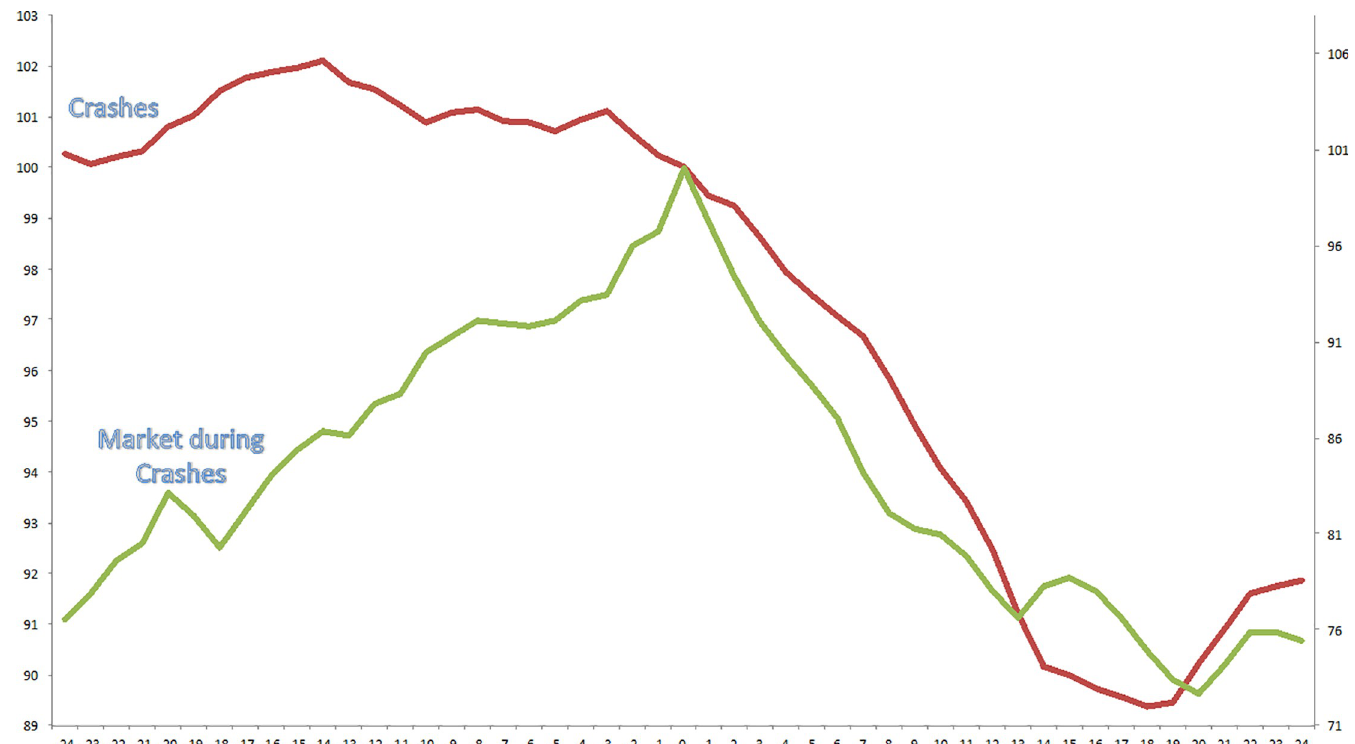
Fig 2. Fear and Euphoria during crashes (1959–2014). The Figure plots cumulative returns to the Euphoria Index EIx (left axis) and the S&P500 (right axis) during periods when US industries experience a large price run-up and a subsequent crash. The sample includes all industries between 1959 and 2012 and is based on Fama and French [39] 49-industry classifications. 30 episodes are identified in which an industry experiences both a raw and net-of-market return of 100% in a two-year period, and a raw return of 50% or more in a five-year period. 15 of these 30 episodes experienced a subsequent crash, and 15 episodes did not. A crash is defined as a 40% drawdown from any point in the two years after the initial price run-up. In the figure’s horizontal axis, 0 denotes the period in which an industry experiences a price peak and subsequently crashes. Both total return indices are normalized to have a value of 100 at this